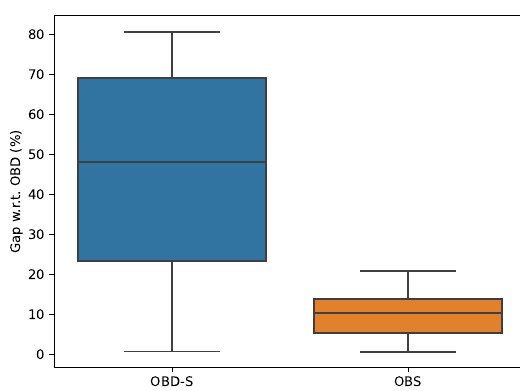
Figure 3. Percentage gaps of OBD-S and OBS with regard to